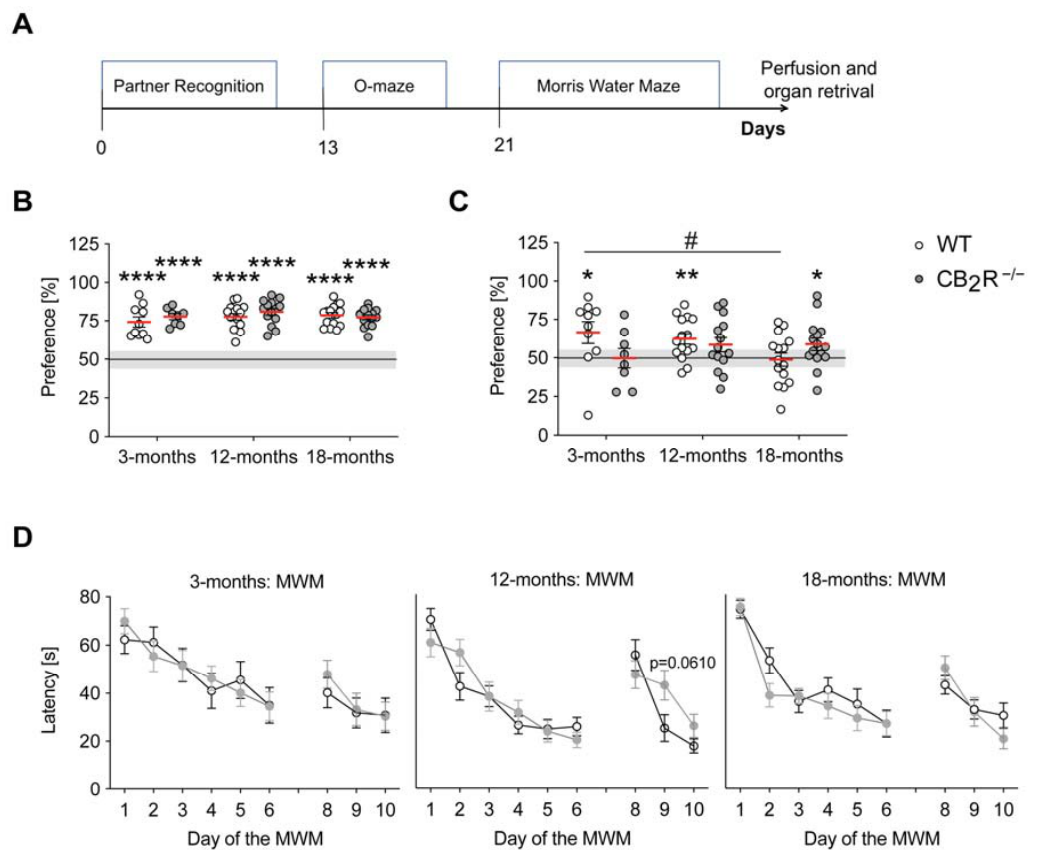
Figure 1. CB 2 R deletion has a moderate age-dependent effect on cognition. ( A ) Experimental timeline: Partner Recognition (PR), O-maze, and Morris Water Maze (MWM). ( B ) Sociability in the PR test was calculated as interaction time with a partner mouse over total interaction time. All groups were social as indicated by mean sociability >50%. ( C ) Preference for the novel partner (after 30 min separation) was calculated as time with the novel partner mouse over total interaction time. Each group was analyzed individually by one-sample t -test (hypothetical mean = 50). Significant difference from the 50% chance level indicated learning (one sample t -test against a hypothetical mean (50%): 3-months WT mice p = 0.0021). * p < 0.05; ** p < 0.01; **** p < 0.0001. Each point represents a single mouse. Red line indicates the mean value ± SEM. Line indicates a 50% chance level. Grey box indicates 5% variance around the chance level. Two-way ANOVA followed by Sidak’s multiple comparison test with # p < 0.05 significance between age groups within the same genotype. ( D ) Acquisition and reversal phase of the MWM. Panels from left to right: 3-, 12- and 18-months old mice. Decrease in the average latency was detected in all groups. RM ANOVA followed by Sidak’s multiple comparison test with exact p -value reported between genotypes within the same age group. WT mice—white circle; CB 2 R − / − mice—grey circles. N = 14–15 mice/genotype/age